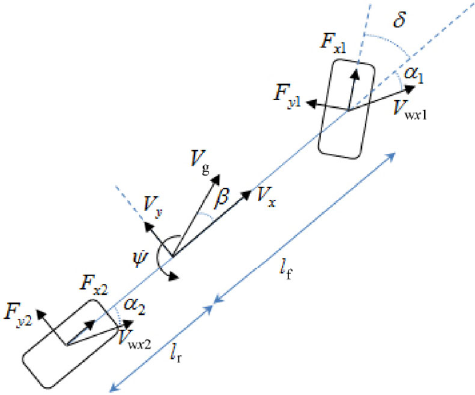
Fig. 11 The schematic of the bicycle model. Table 4 Some studies which have used bicycle